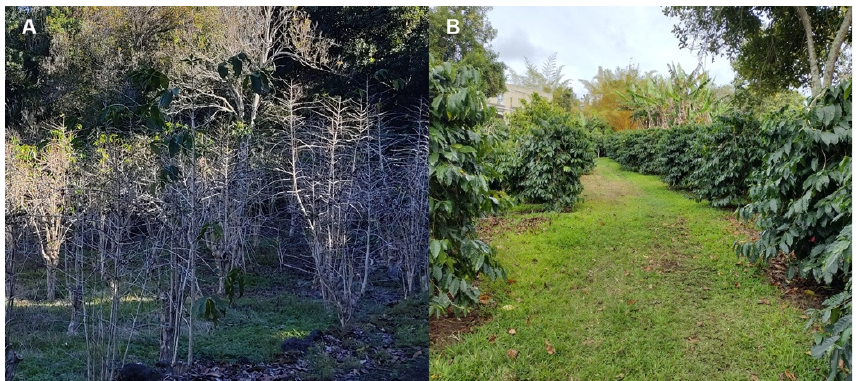
Figure 7. High levels of defoliation were observed at a farm in Kona with poor agronomic manage- ment and inefficient application of preventative fungicides ( A ), compared to a farm in Kona with good management and efficient applications of preventative and systemic fungicides that ended the season with no defoliation ( B ). Both photographs were taken in March 2022. Photos by Luis F. Aristiz á